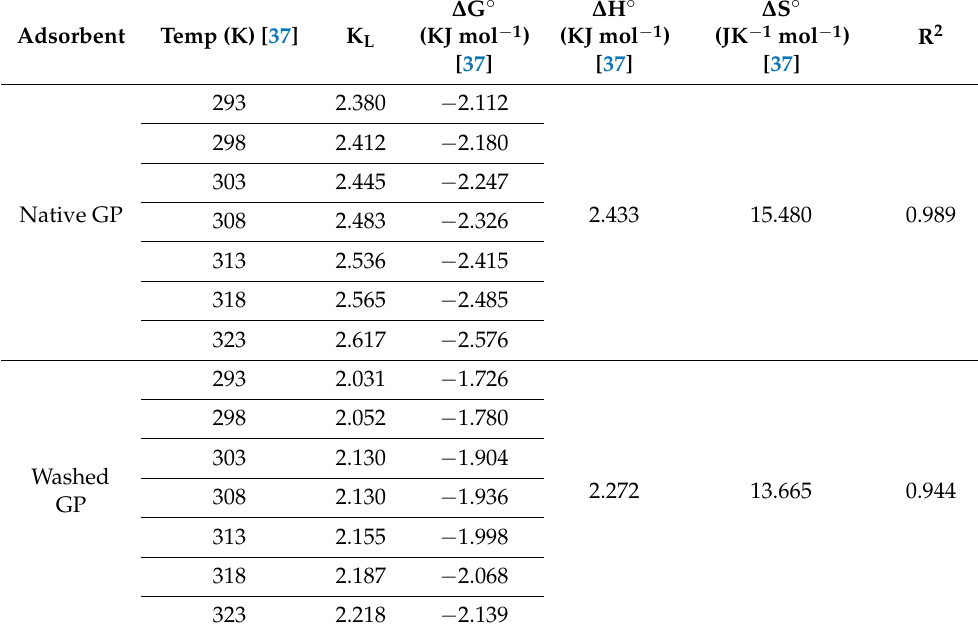
Table 3. Thermodynamic parameters for EBT adsorption on native and washed